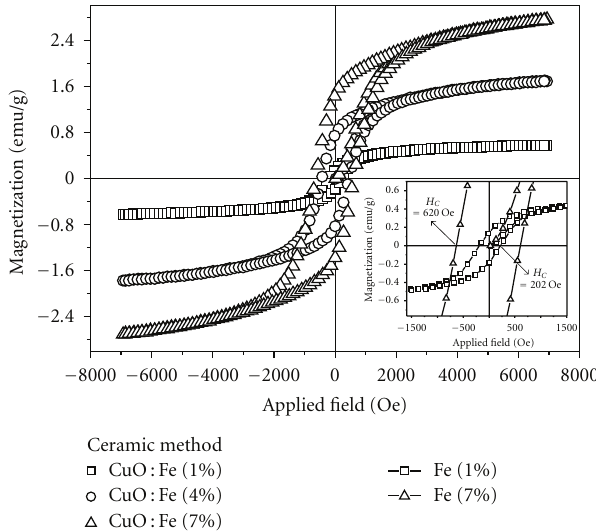
Figure 13: Hysteresis loop of 1%, 4%, and 7% “Fe”-doped bulk CuO at 300K. Inset shows the large variation in coercivity of 1% and 7% “Fe”-doped